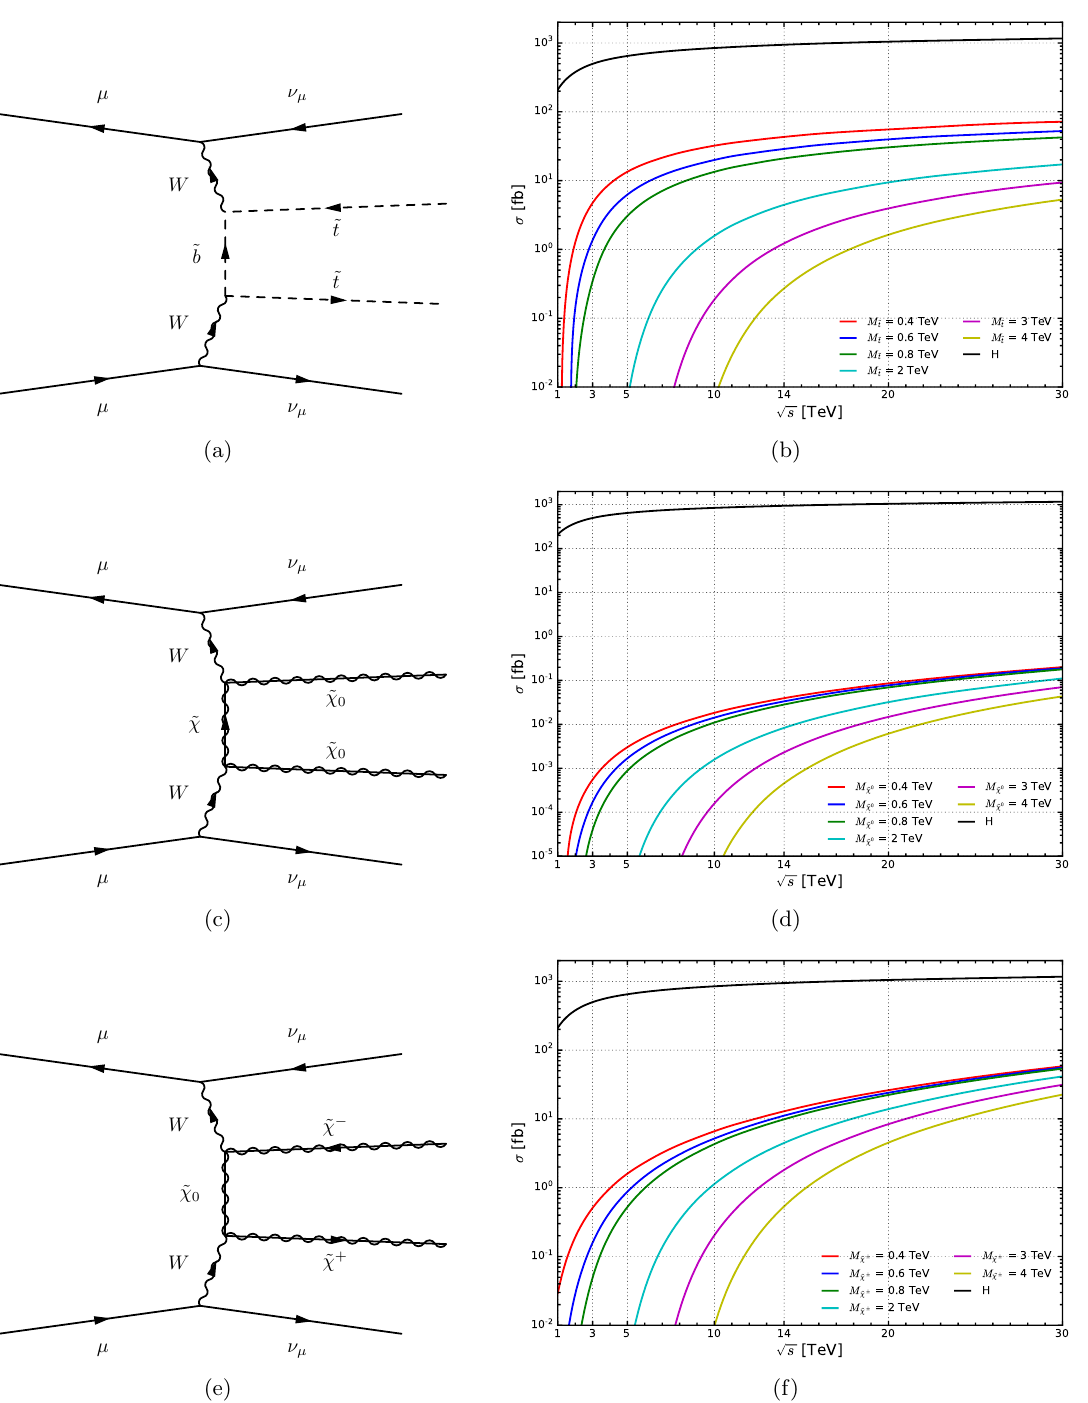
Figure 12 . Same as (cid:12)gure 10 but in the MSSM for (a,b) stop pair production, (c,d) neutralino pair production, and (e,f) chargino pair production.